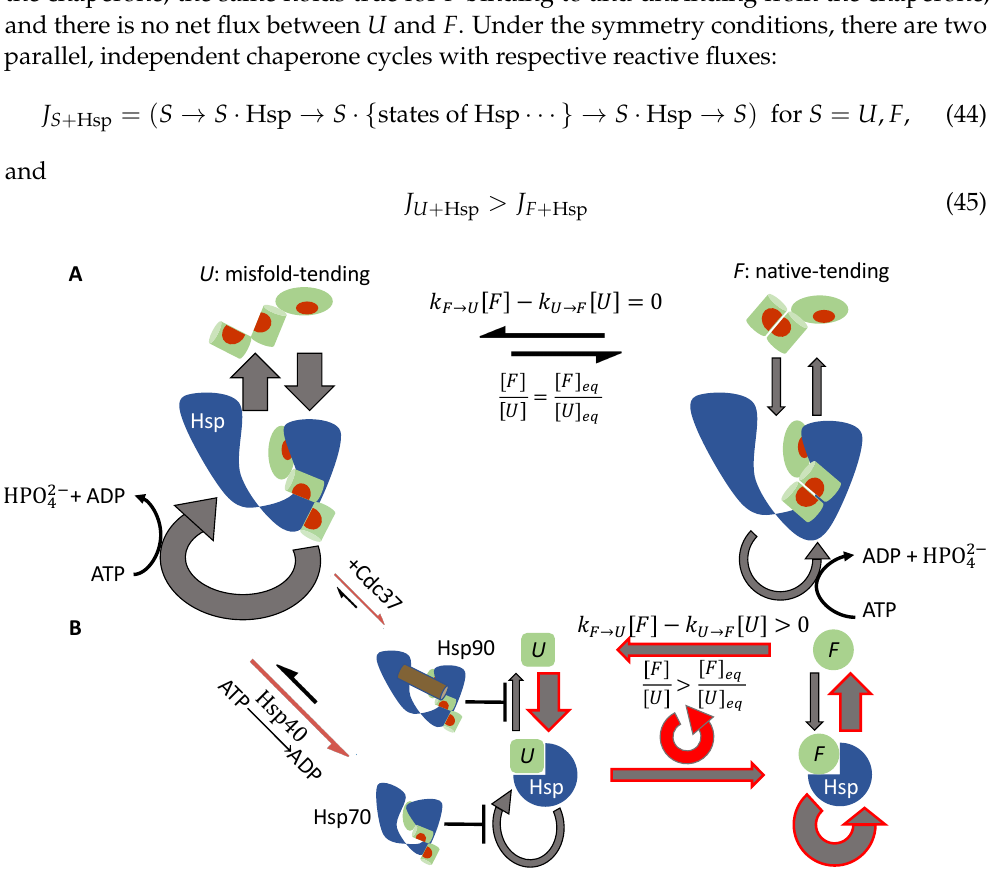
Figure 4. Reactive flux in chaperone-mediated non-equilibrium protein folding. ( A ) Under the symmetry conditions, there are two independent ATP-driven chaperone cycles: one with a higher reactive flux for a substrate in the misfold-tending ( U ) conformation (left) and one with a lower reactive flux for a substrate in the native-tending ( F ) conformation (right). There is no net flux between the substrate’s two conformations, and the ratio [ F ] / [ U ] is the same as its chaperone-free equilibrium value. ( B ) Cochaperones break the kinetic symmetry. The release of a substrate in the U conformation from the chaperone is inhibited: Cdc37 assists Hsp90 with retaining the substrate and Hsp40 stimulates ATP hydrolysis and closure of Hsp70. This restricts the reactive flux to release a substrate in the U conformation, forcing a partial diversion of the flux to the conformation conversion from U · Hsp to F · Hsp and resulting in a net reactive flux of U → U · Hsp → F · Hsp → F → U (red cycle), which elevates the ratio [ F ] / [ U ] above its chaperone-free equilibrium